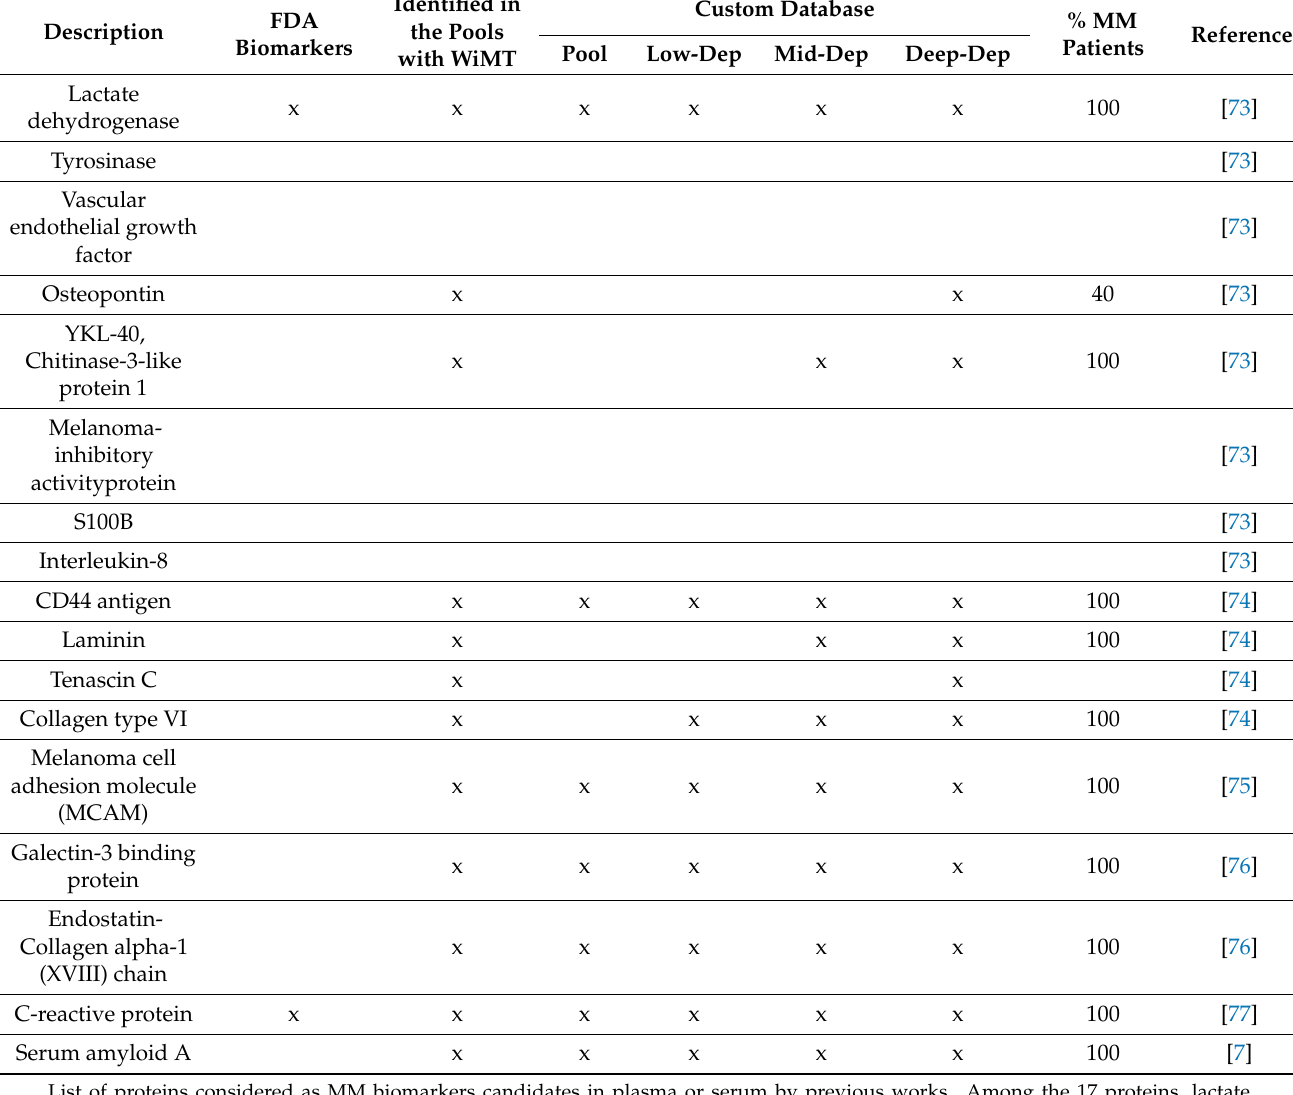
List of proteins considered as MM biomarkers candidates in plasma or serum by previous works. Among the 17 proteins, lactate dehydrogenase and C-reactive protein have been approved by the FDA. Using the WiMT strategy, we were able to identify 12 proteins in the pools and 11 in individual plasma from MM patients. The immunodepleted strategies were important for the identification of osteopontin, chitinase-3-like protein 1, laminin, tenascin C, and collagen type VI. The percentage of MM patients that had proteins identified with WiMT was calculated, and most were identified in all the 10